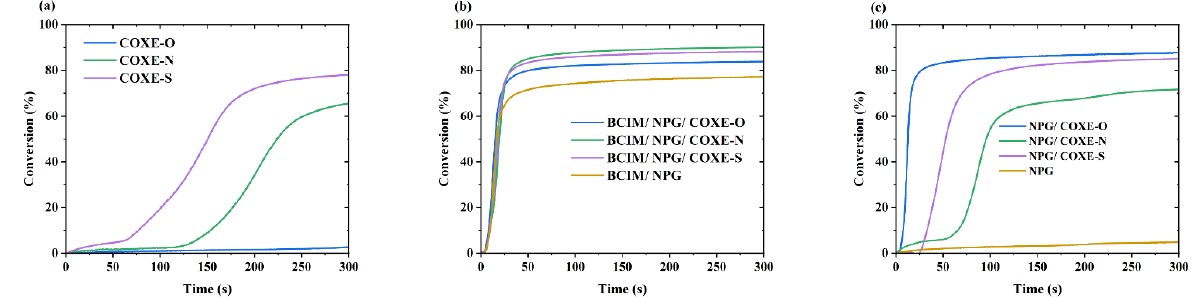
Figure 10. C=C double bond conversion curves for TPGDA polymerization initiated by Iod- PF 6 /COXE-O under 400 nm LED irradiation (photo intensity:100 mW · cm − 2 ) for 100 s. ( a ) COXE-O concentrations of 0, 1.2 × 10 − 6 , 2.4 × 10 − 6 respectively and 4.8 × 10 − 6 mol · g − 1 , and Iod-PF 6 concentration of 6.0 × 10 − 5 mol · g − 1 , ( b ) COXE-O concentration of 2.4 × 10 − 6 mol · g − 1 and Iod-PF 6 concentrations of 0, 2.4 × 10 − 6 , 1.2 × 10 − 5 and 6.0 × 10 − 5 mol · g -1 respectively.